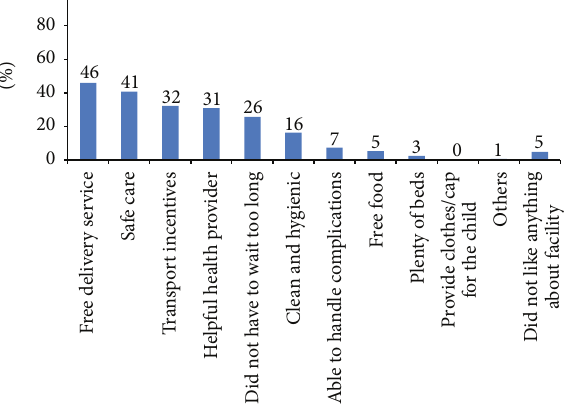
Figure 4: Maternity clients’ recommendations according to level of satisfaction ( 𝑁 = 447